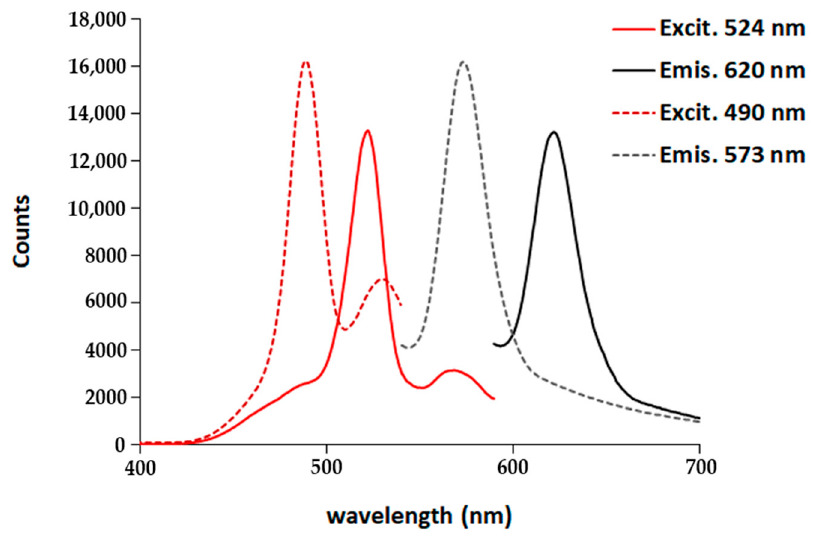
Figure 10. Luminescence spectra of a solution of 1 (2.00 mM) + But 4 NOH (2.00 mM) at excitation wavelengths 524 nm (solid line) and 490 nm (dashed line).